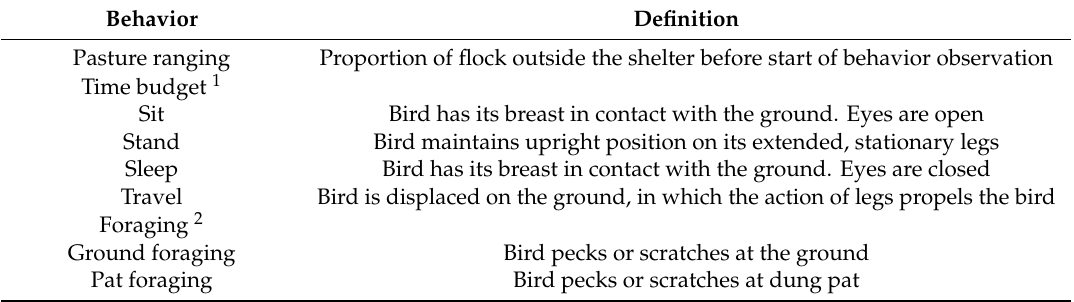
Table 1. Ethogram of behaviors recorded before and during 60-s observation periods. Modified from Ventura et al.